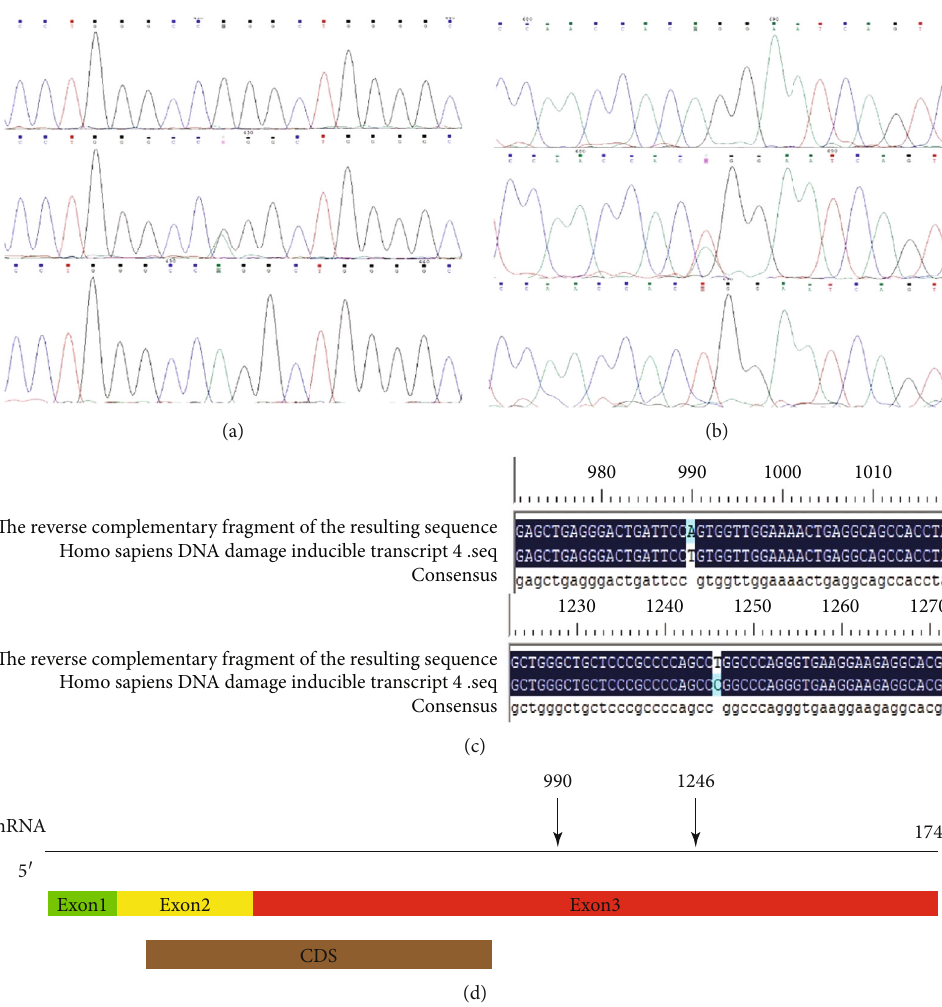
Figure 1: Gene mutation of DDIT4. (a, b) The reverse sequencing map gene of enrolled patients with pancreatic cancer. (c) The result of gene mutation blast match Homo sapiens DNA damage-inducible transcript 4 (DDIT4), mRNA (LOCUS: NM_019058); the blue one is the mutation point (m.990 and m.1246). (d) The two mutation sites of DDIT4 mRNA were located at exon 3 and 3 ′